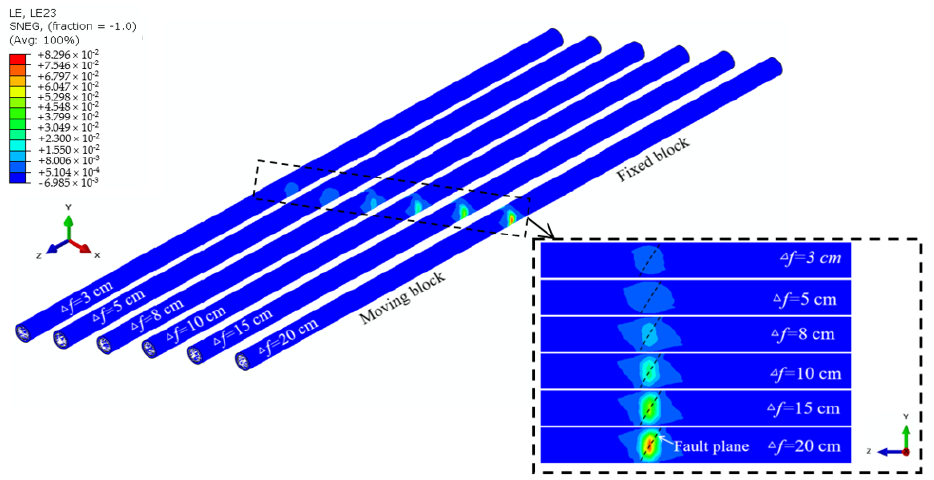
Figure 4. Circumferential shear strain nephogram of composite lining structures under different fault displacements ( β = 60°;